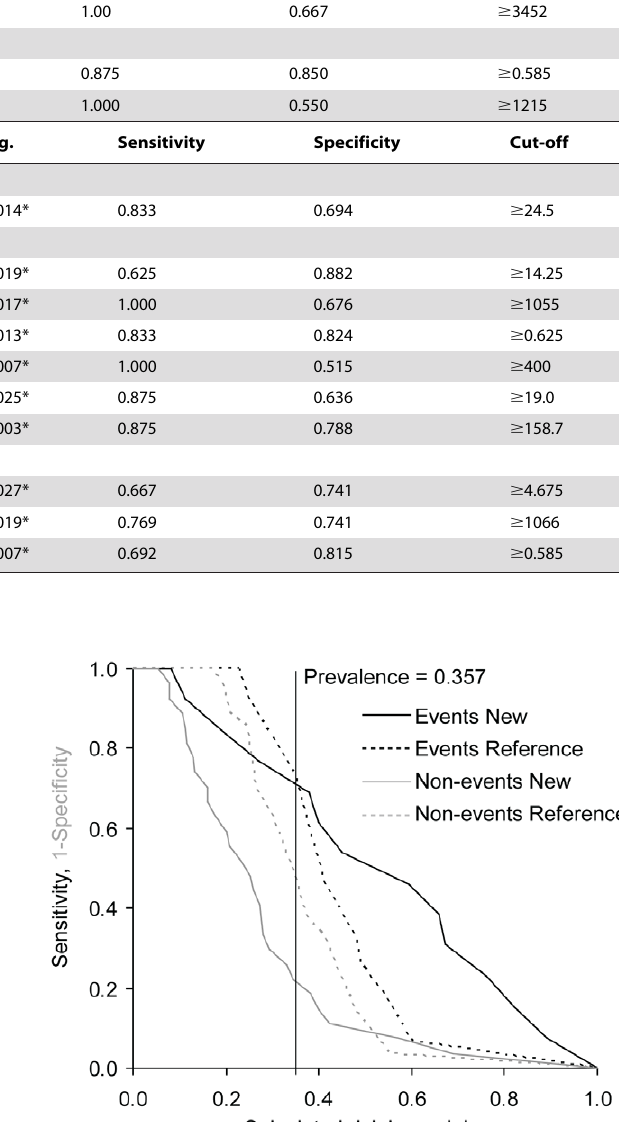
Figure 2. Risk assessment plot of the performance comparison between reference EuroSCORE model and new EuroSCOR- E + MDA model for combined endpoint at 30 days in TAVI +- SAVR group (N=42).